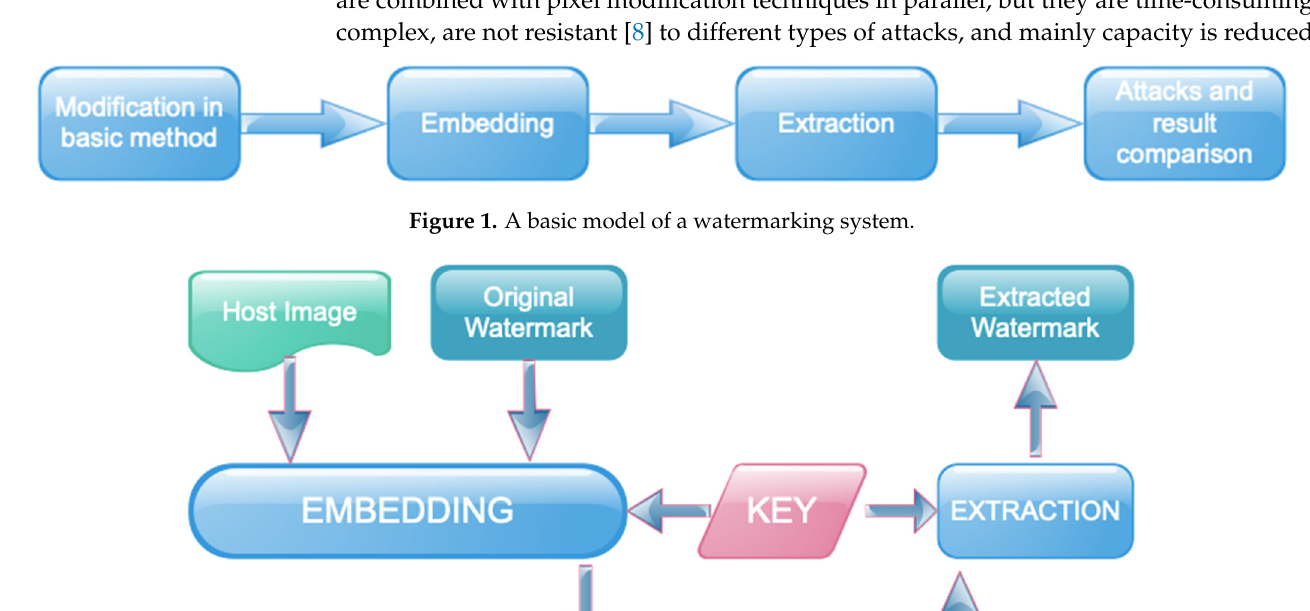
Figure 1. A basic model of a watermarking system.